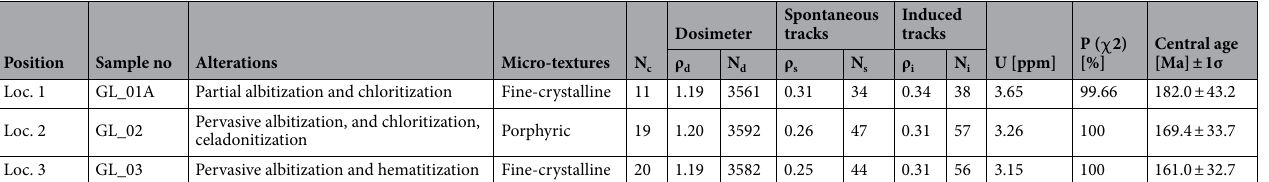
Table 8. Apatite fission-track ages and sample details for the rocks collected from various areas of Głuszyca trachyandesite laccolith. Nc—number of crystals; ρs,ρi,ρd —density of spontaneous, induced and detector tracks, respectively (× 10 6 tracks for cm −2 ); Ns, Ni, Nd —number of counted spontaneous, induced and detector tracks; P ( χ 2 )—probability obtaining Chi-square value for n degree of freedom (where n = no. crystals-1 80 . AFT data corresponds to central ages ± 1σ uncertainty. The external detector method and the ζ calibration approach was used to determine the fission tracks age 77,78 ), with theζ values of 348.18 ± 6.52 for CN5 glass dosimeters (operator: A.A. Anczkiewicz). Note the separation of apatite failed for sample GL_01B.